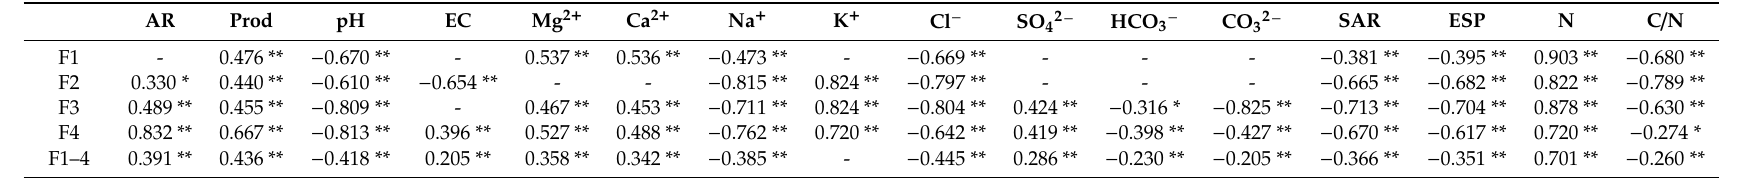
Table 8. Pearson’s correlation coe ffi cient among carbon, application rate, corn production, and soil chemical properties.